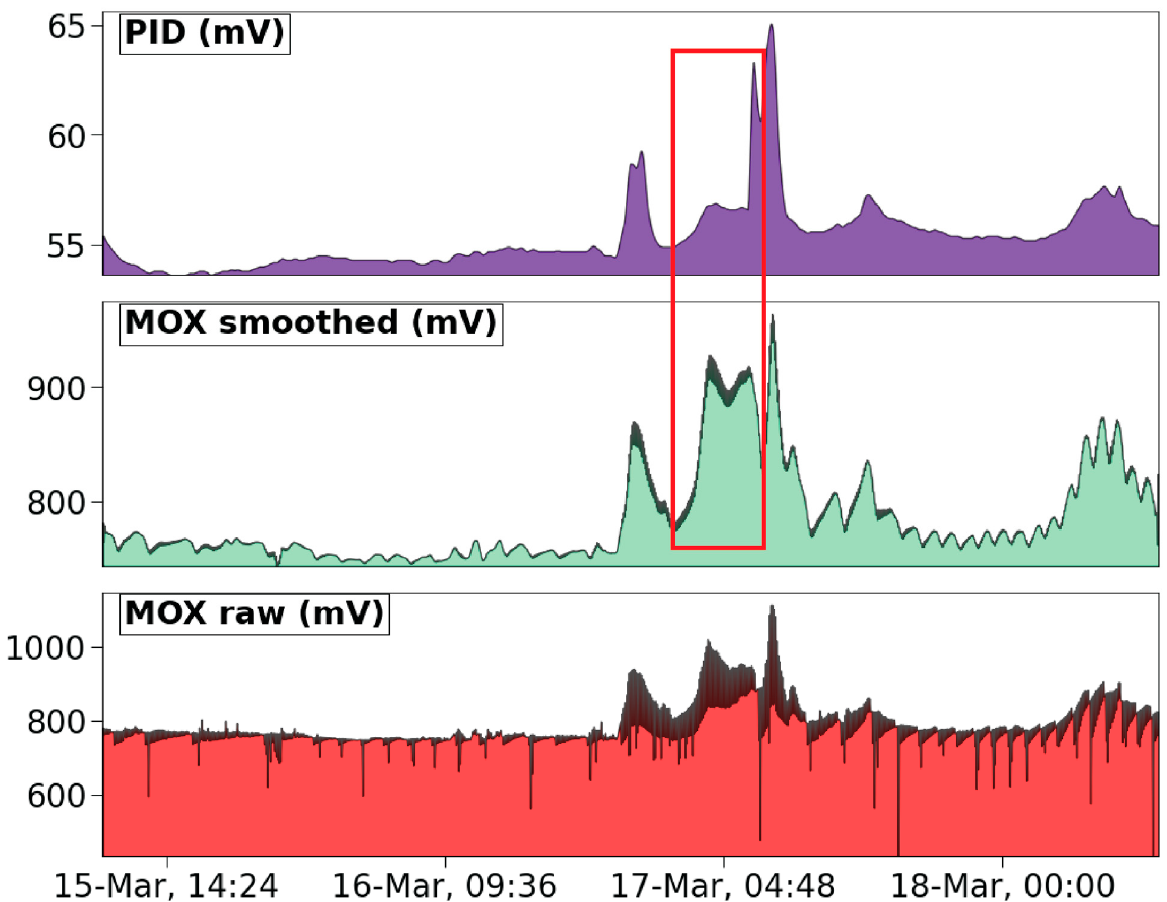
Figure 4. Measured TVOC-signal in mV over time and measured in the engine room during the same campaign as in Figures 2 and 3. The trends are measured with a PID and MOX-sensor. The signal of the MOX-sensor is smoothed by a seven-point central moving median followed by a seven-point central moving average. The scale for MOX raw and MOX smoothed is different because the Y -axis of MOX raw is affected by the amplitude of the high frequency fluctuation. The red box is a detail where the peak ratios are different for PID and MOX sensor.